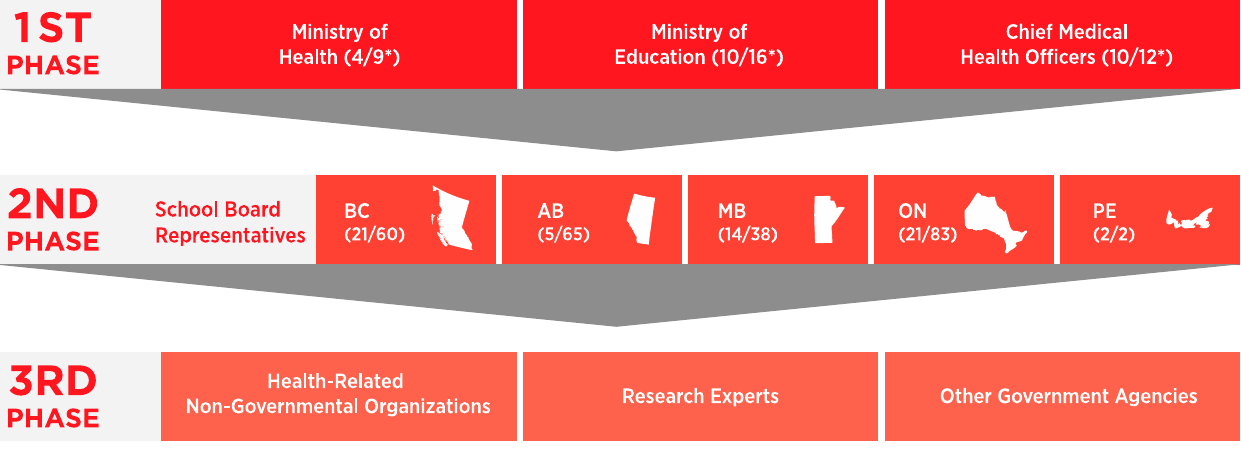
Figure 1. Data collection method and response rates for each level of knowledge gatekeepers.